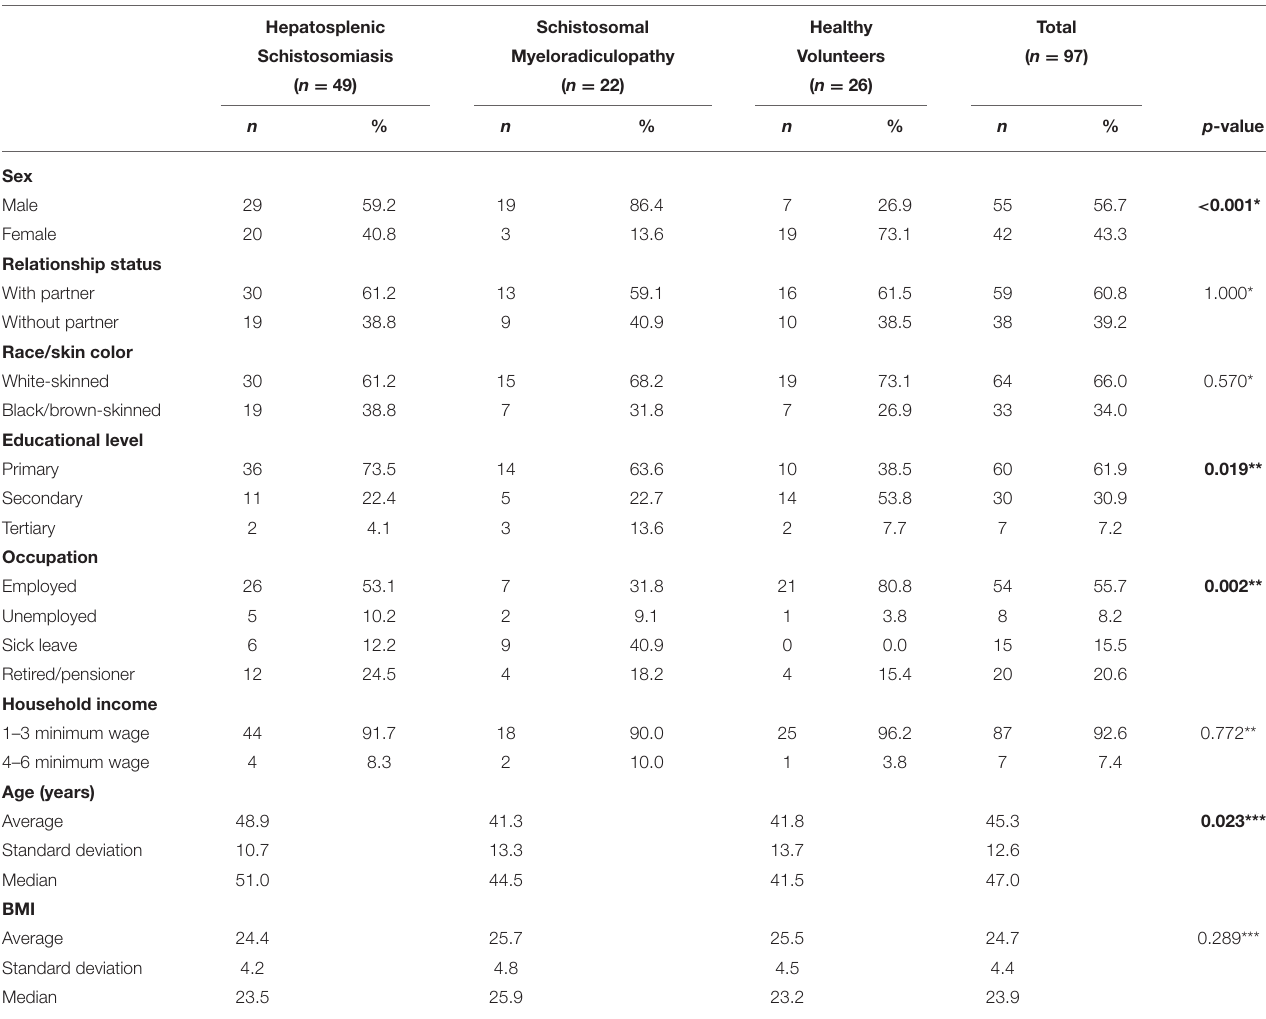
TABLE 1 | Socio-demographic data of schistosomiasis patients and healthy volunteers included in this study. Hepatosplenic Schistosomal Healthy Total Schistosomiasis Myeloradiculopathy